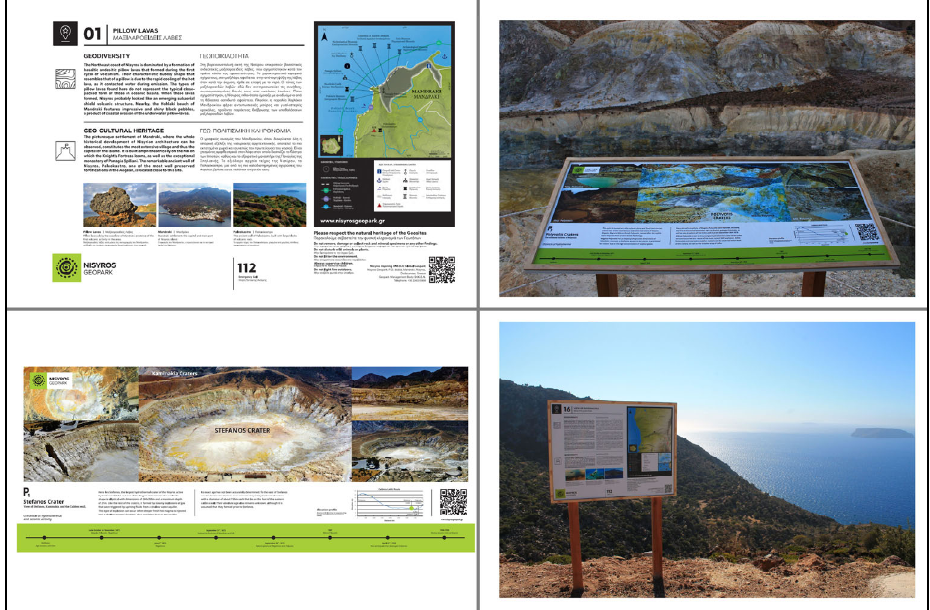
Figure 19. Examples of informative signs and panels at each geosite. ( Upper left ) Prototype layout of informative sign with dimensions of 60 × 40 cm, regarding the pillow lavas at Mandraki, Geosite 1; ( Upper right ) Informative panel installed at Megalos and Mikros Polyvotis craters, Geosites 8 and 9, respectively, and Point of Interest 3 at Lakki; ( Lower left ) Prototype layout of the informative panel at Stefanos, Geosite 5 and Point of Interest 1 of Lakki; ( Lower right ) Composite informative sign with dimensions 70 × 90 cm, regarding view of rhyodacites and the islets Pachia and Pergoussa, Geosites 16, 23 and 24 respectively.